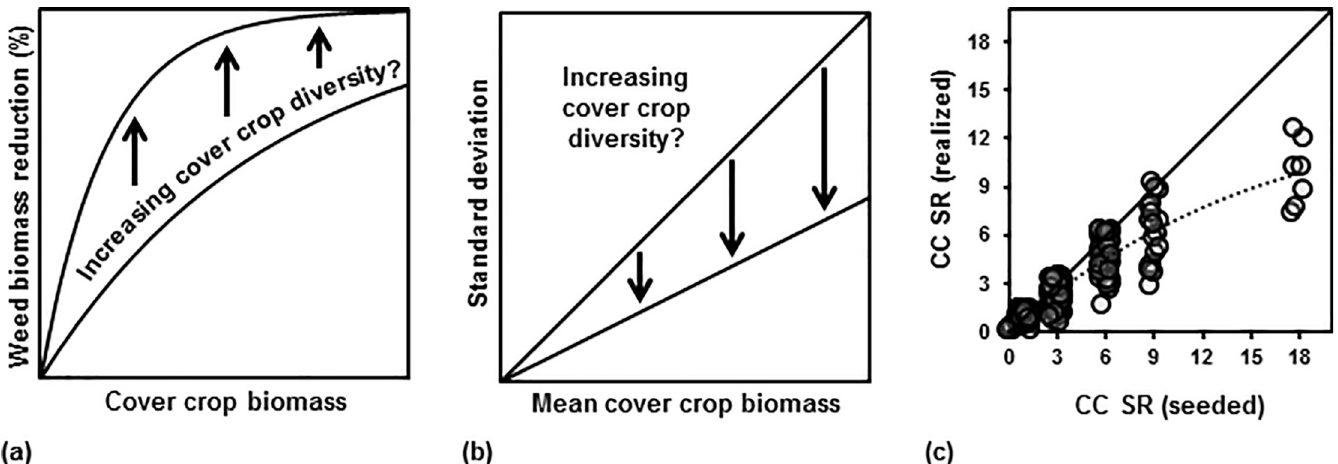
Fig 1. Hypothesized effect of species diversity on invasibility and stability. (a) Effect of increasing cover crop diversity (species or functional richness) on the relationship between weed biomass reduction and cover crop biomass. (b) Effect of increasing cover crop diversity on the relationship between standard deviation of cover crop biomass and mean cover crop biomass. (c) Realized cover crop species richness versus seeded cover crop species richness. Points jittered along both axes for ease of viewing. Solid line shows an idealized 1:1 relationship. Dashed line shows LOESS curve fitted to data ( α = 1, λ = 2).